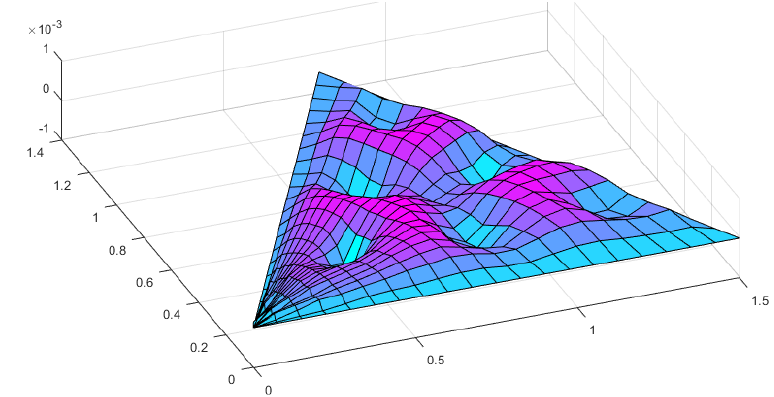
Fig. 23. Isometric view of the deflections